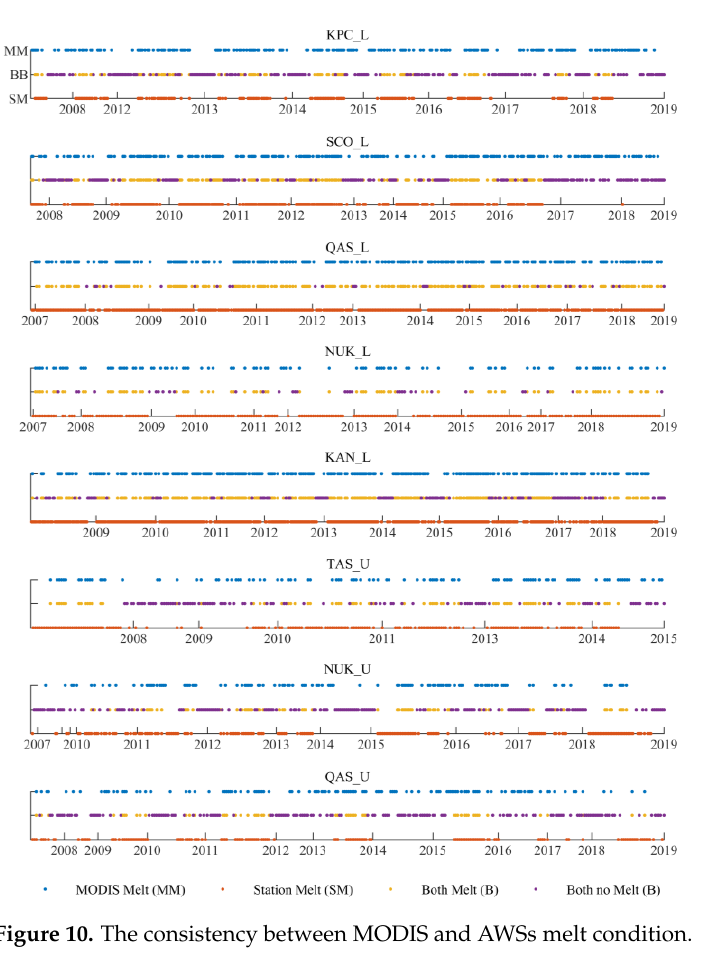
Figure 10. The consistency between MODIS and AWSs melt condition.